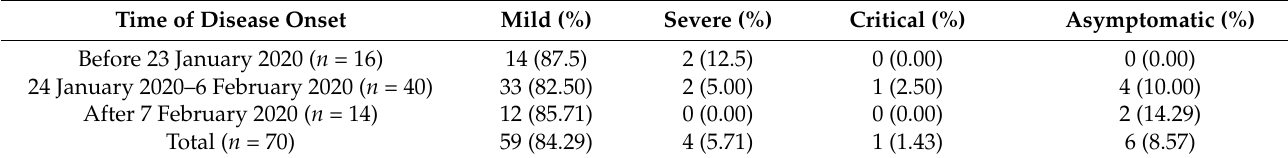
Table 2. Symptoms of disease in infected students.